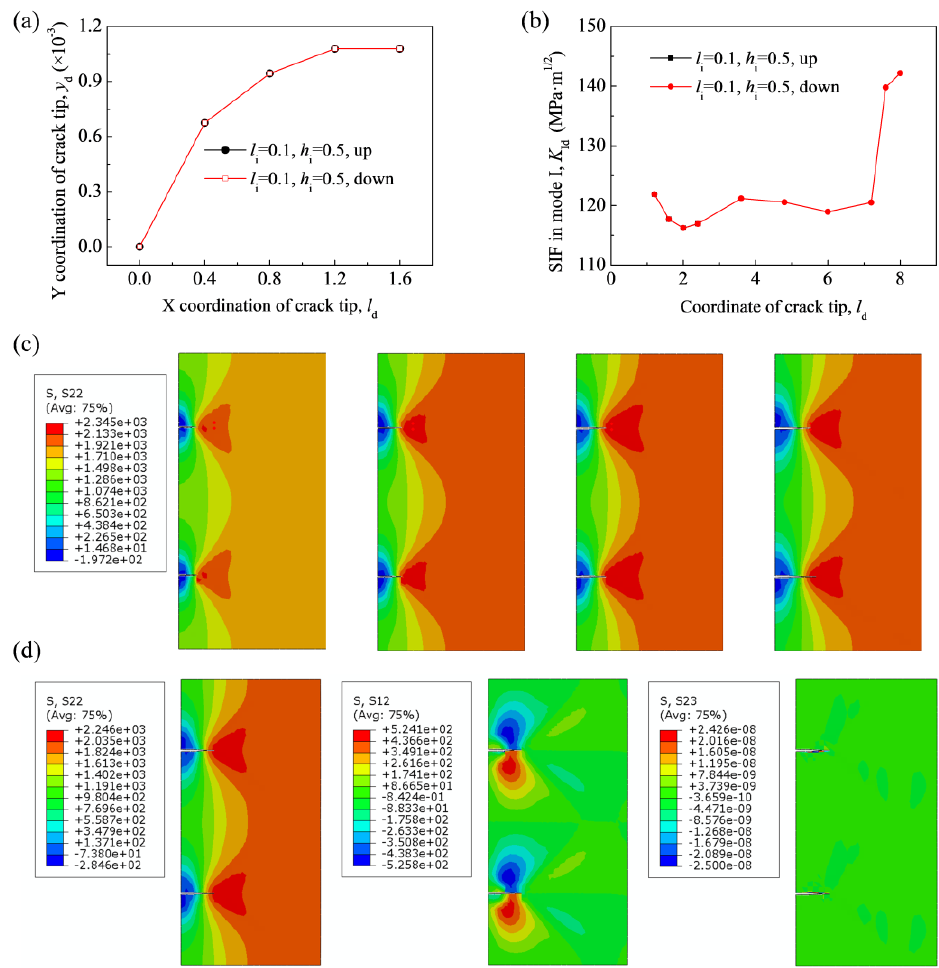
Figure 7. ( a ) Crack propagation path; ( b ) K Id in the propagation process for a 2-crack model with an initial length 0.1; ( c ) S 22 stress contours in the crack propagation process; ( d ) Comparison of stress contours in three orientations when the crack propagates to 0.4.